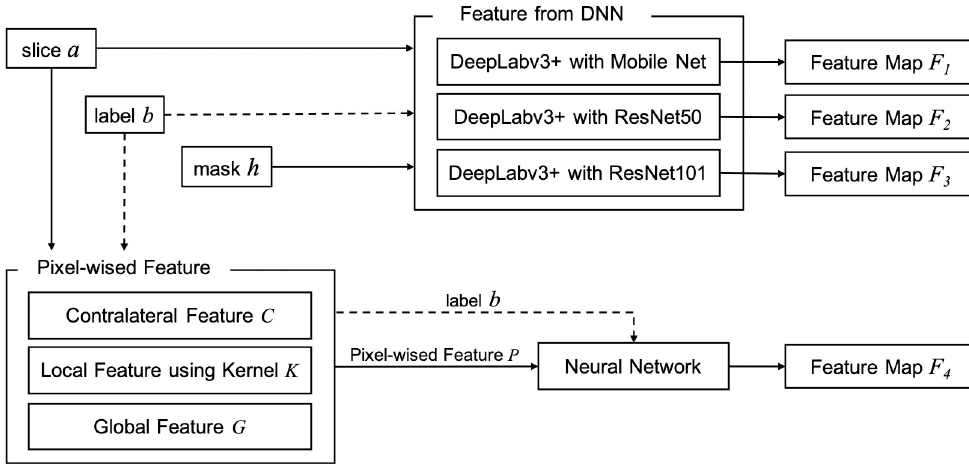
Fig 4. The architecture of the input for the proposed DNN.